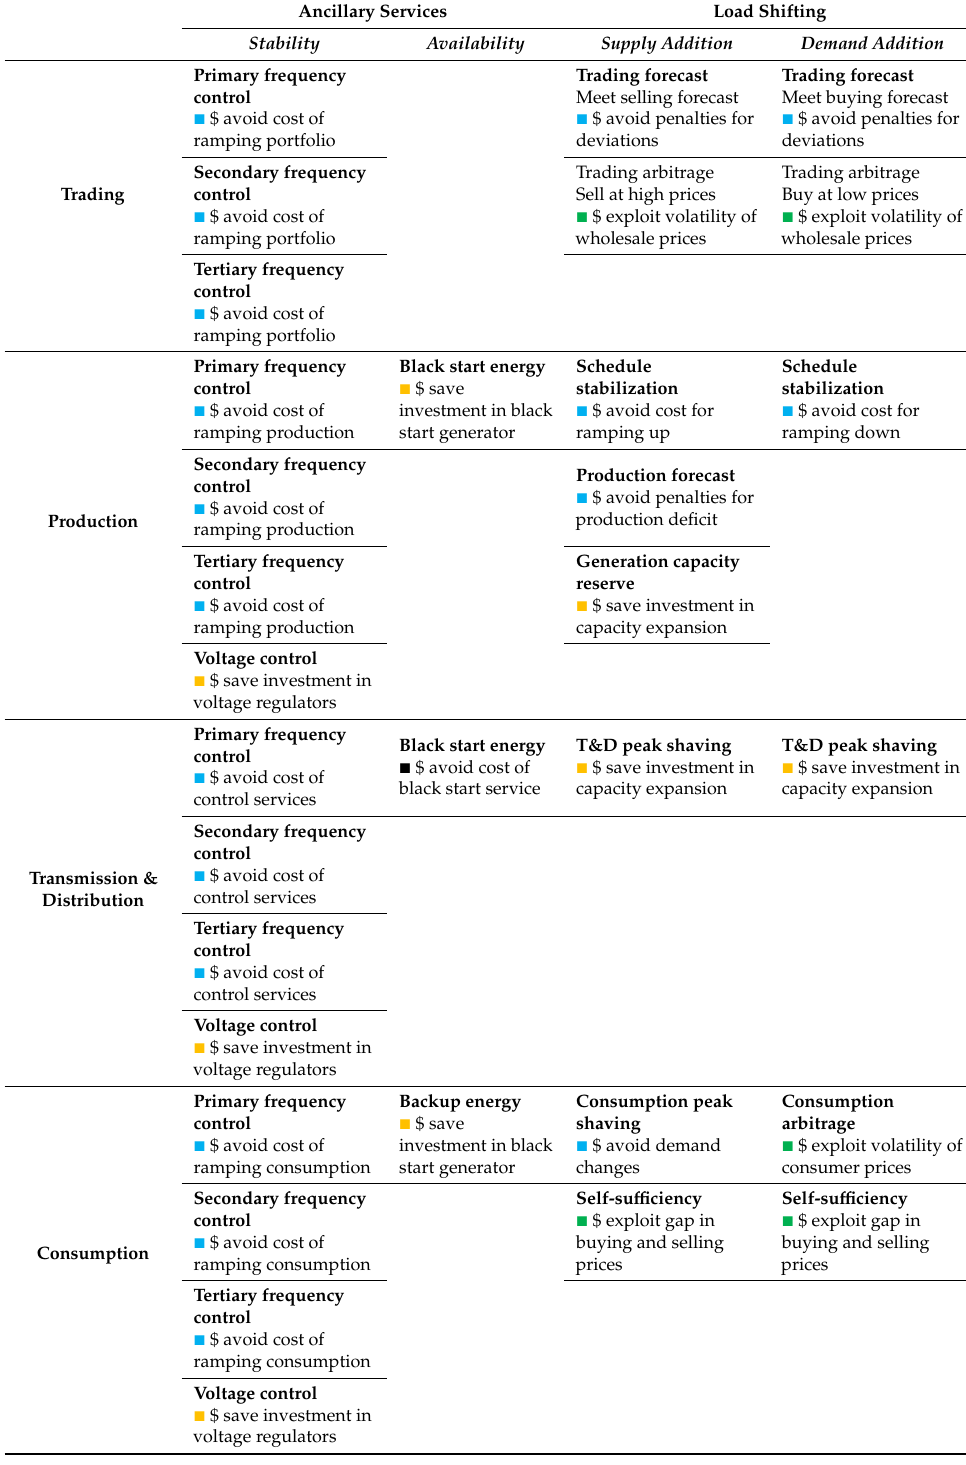
Table 20. Business model framework for energy storage. Rows display market roles, columns value propositions, and colored dots revenue streams. Cells specify the business model around an